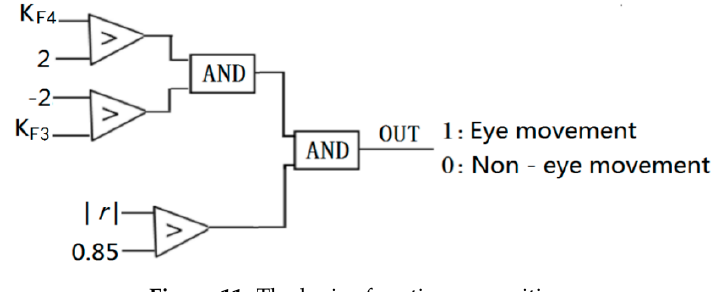
Figure 11. The logic of motion recognition.